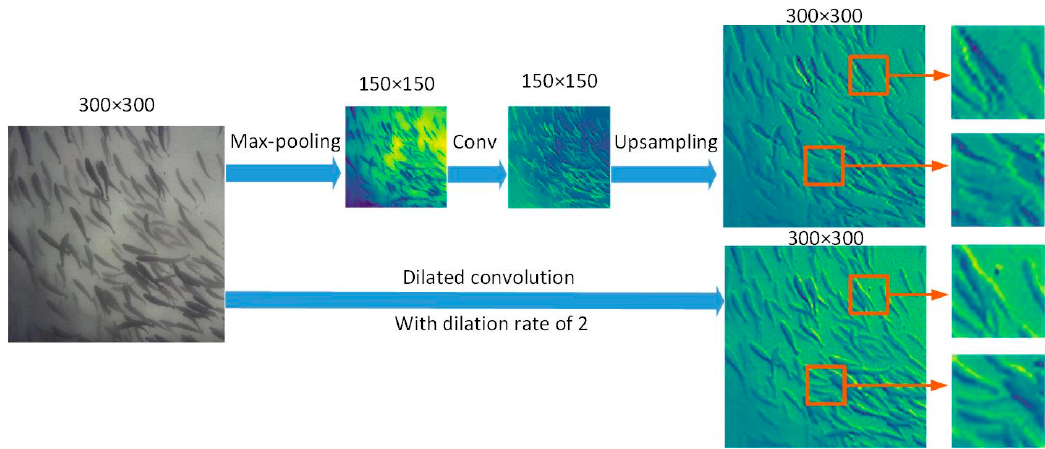
Figure 12. Comparison between dilated convolution and max-pooling, convolution, and upsampling.